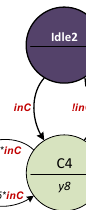
Figure 8. The slave FSM ( C_region2 ) with history mechanism.